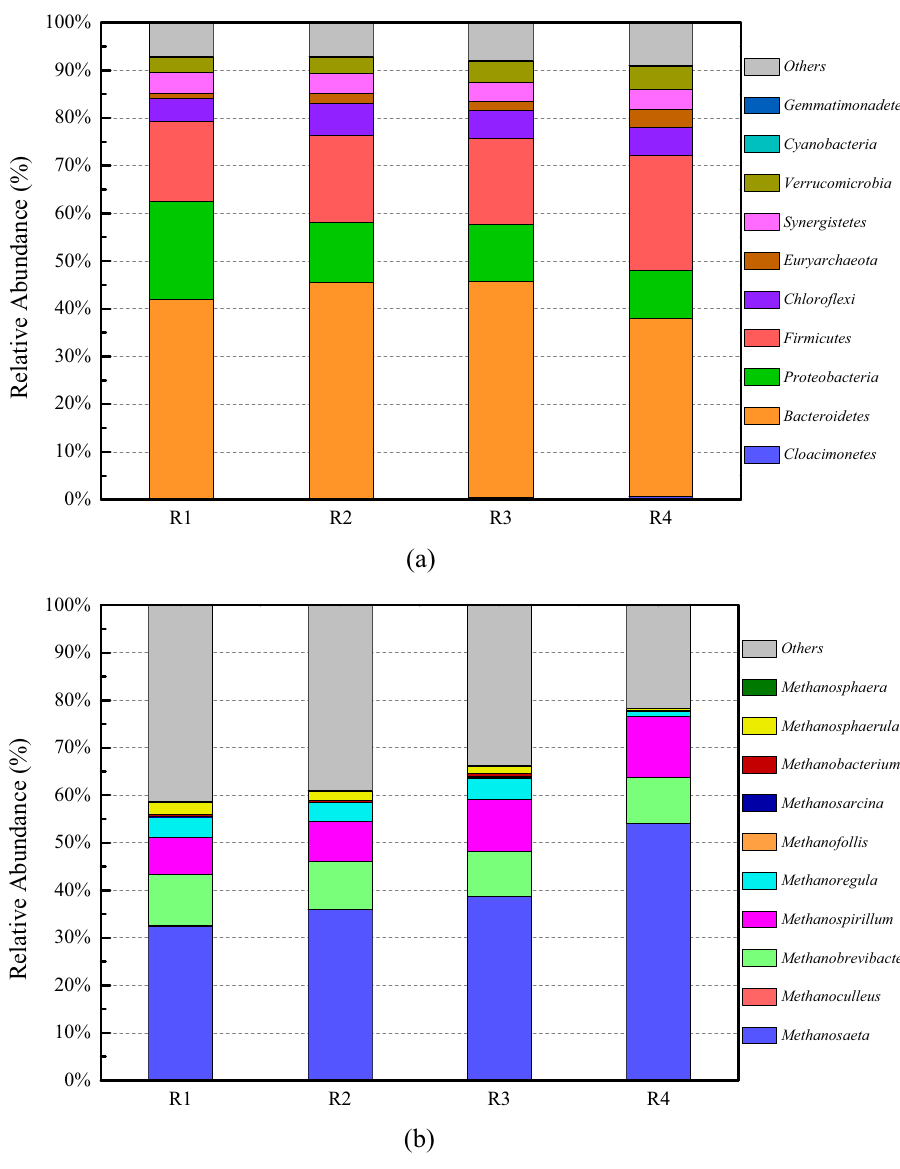
Figure 5: The relative abundance of microbial communities at the phylum levels ( a ) and the methanogenic microbial community at the genus level ( b ) in the peak gas production of anaerobic digestion system of cattle manure under conditions of the sub - mesophilic